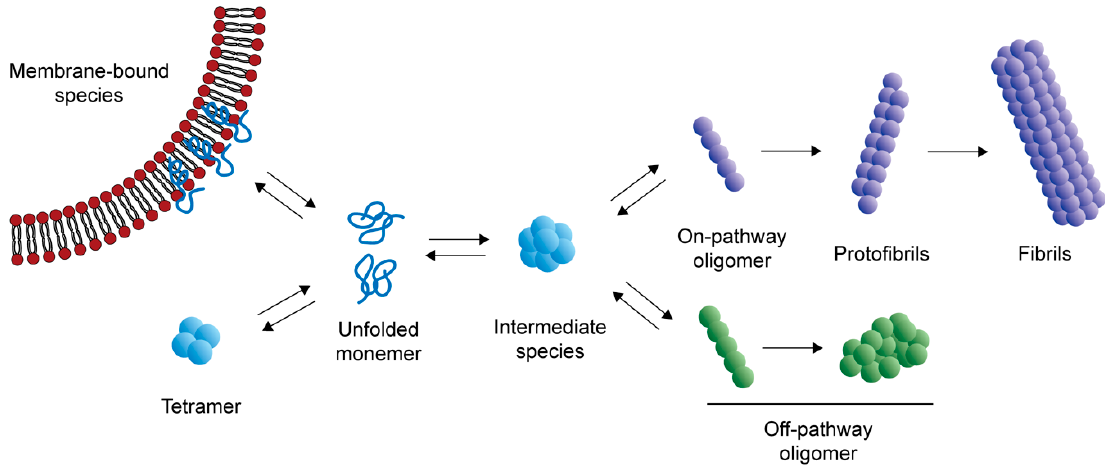
Figure 1. The process of α -syn aggregation. Under physiological conditions, α -syn exists as unfolded monomers, in equilibrium with membrane-bound species that promote SNARE-complex assembly and tetramers that can resist abnormal aggregation. When the balance between α -syn generation and clearance is disrupted, the monomers aggregate to form oligomers, including on-pathway oligomers and off-pathway oligomers. On-pathway oligomers tend to form protofibrils, and eventually fibrils. Other oligomers that cannot form amyloid fibrils are called off-pathway oligomers.